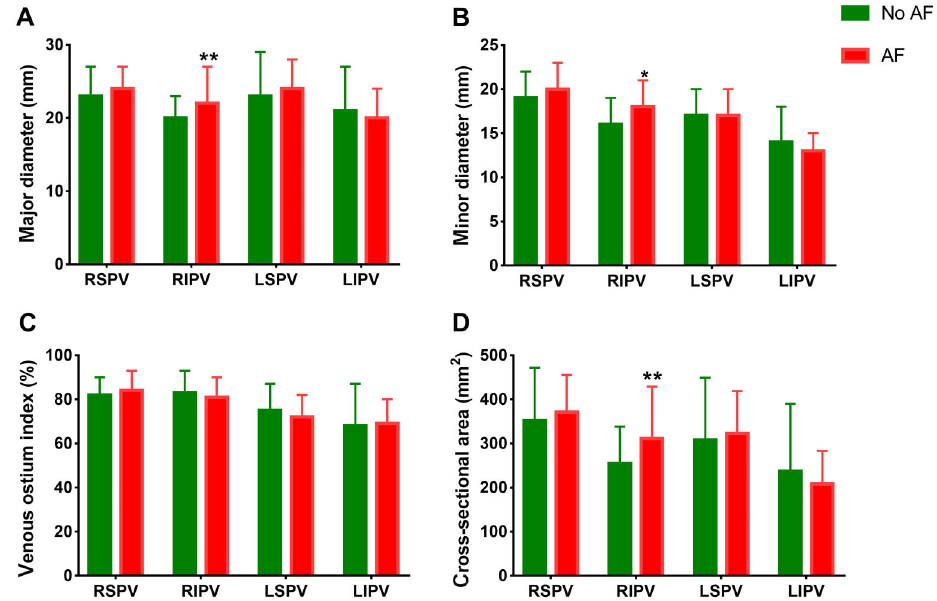
Figure 1. Parameters of pulmonary veins. AF: atrial fi brillation; RSPV: right superior pulmonary vein; RIPV: right inferior pulmonary vein; LSPV: left superior pulmonary vein; LIPV: left inferior pulmonary vein. Data are reported as means ± SD *P o 0.05, **P o 0.01 between groups (Student ’ s t -test or Mann-Whitney U